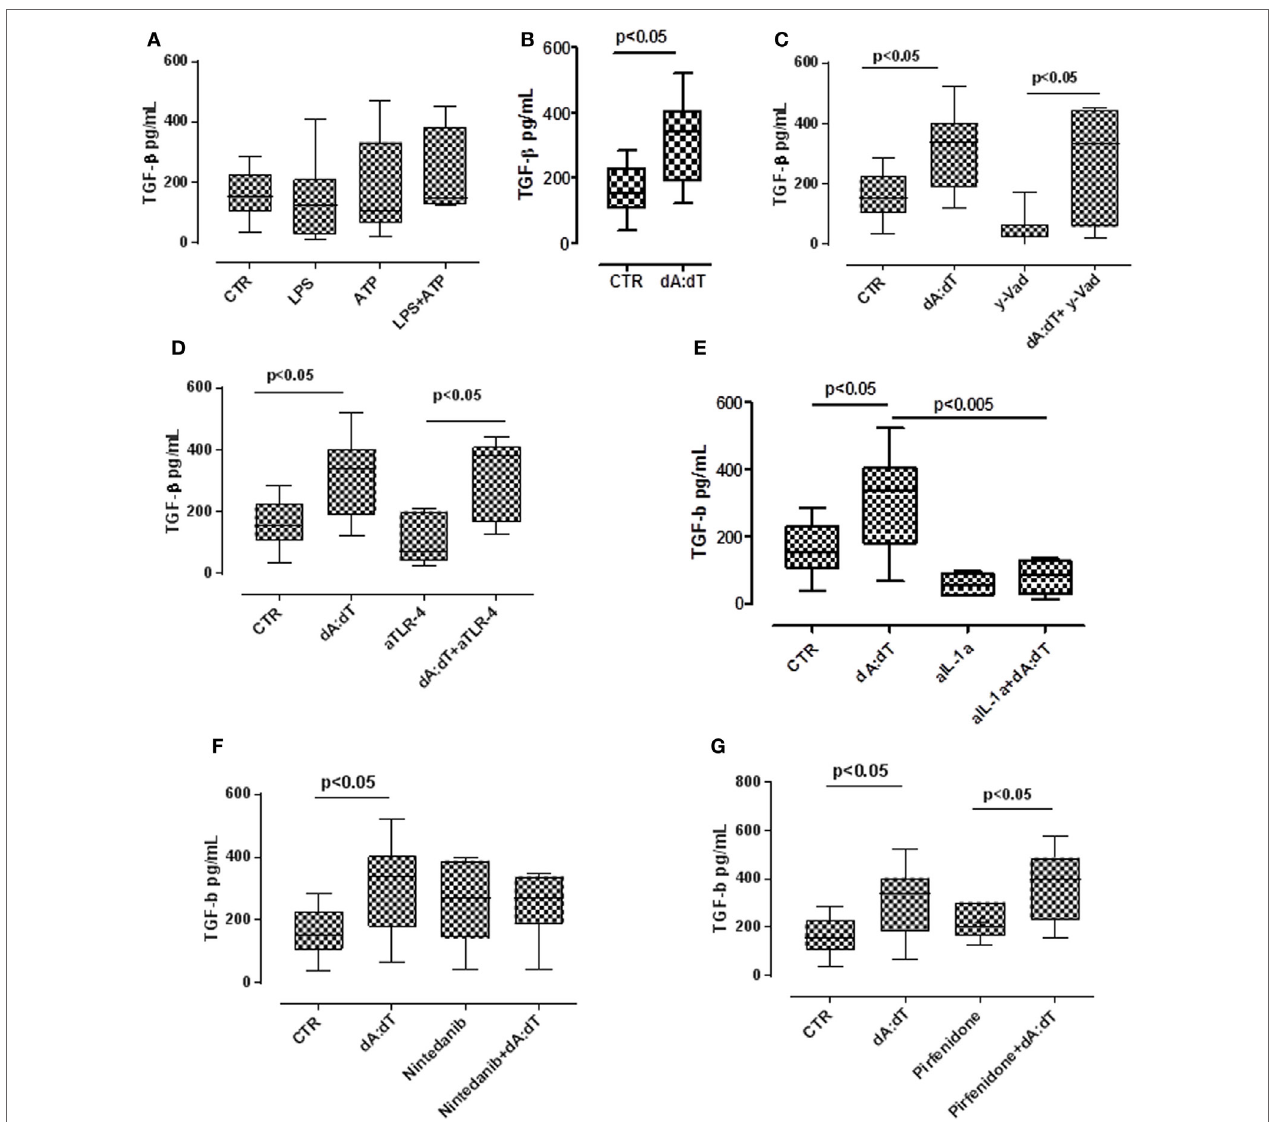
FigUre 5 | The activation of absent in melanoma 2 inflammasome induces the release of the pro-fibrotic TGF- β . (a) Treatment with LPS ± ATP for 24 h induced the release of TGF- β from idiopathic pulmonary fibrosis (IPF) peripheral blood mononuclear cells (PBMCs), although not was a statistical significant manner. (B) Poly dA:dT (dA:dT) stimulation significantly increased the release of TGF- β from IPF-derived PBMCs. The inhibition of caspase-1 with Ac-y-Vad (y-Vad) did not reduce TGF- β release after (c) dA:dT treatment. The neutralization of TLR4 did not reduce TGF- β release after dA:dT treatment (D) . Instead, the neutralization of IL-1 α significantly reduced TGF- β release (e) . In sharp contrast, the addition of nintedanib (10 nM) (F) or pirfenidone (g) did not alter dA:dT-induced TGF- β release. Data are represented as median ± interquartile range ( n = 13). Statistically significant differences were determined by one-way ANOVA followed by Bonferroni’s multiple comparison post-test or Student’s t -test and Fischer’s exact test as appropriate.